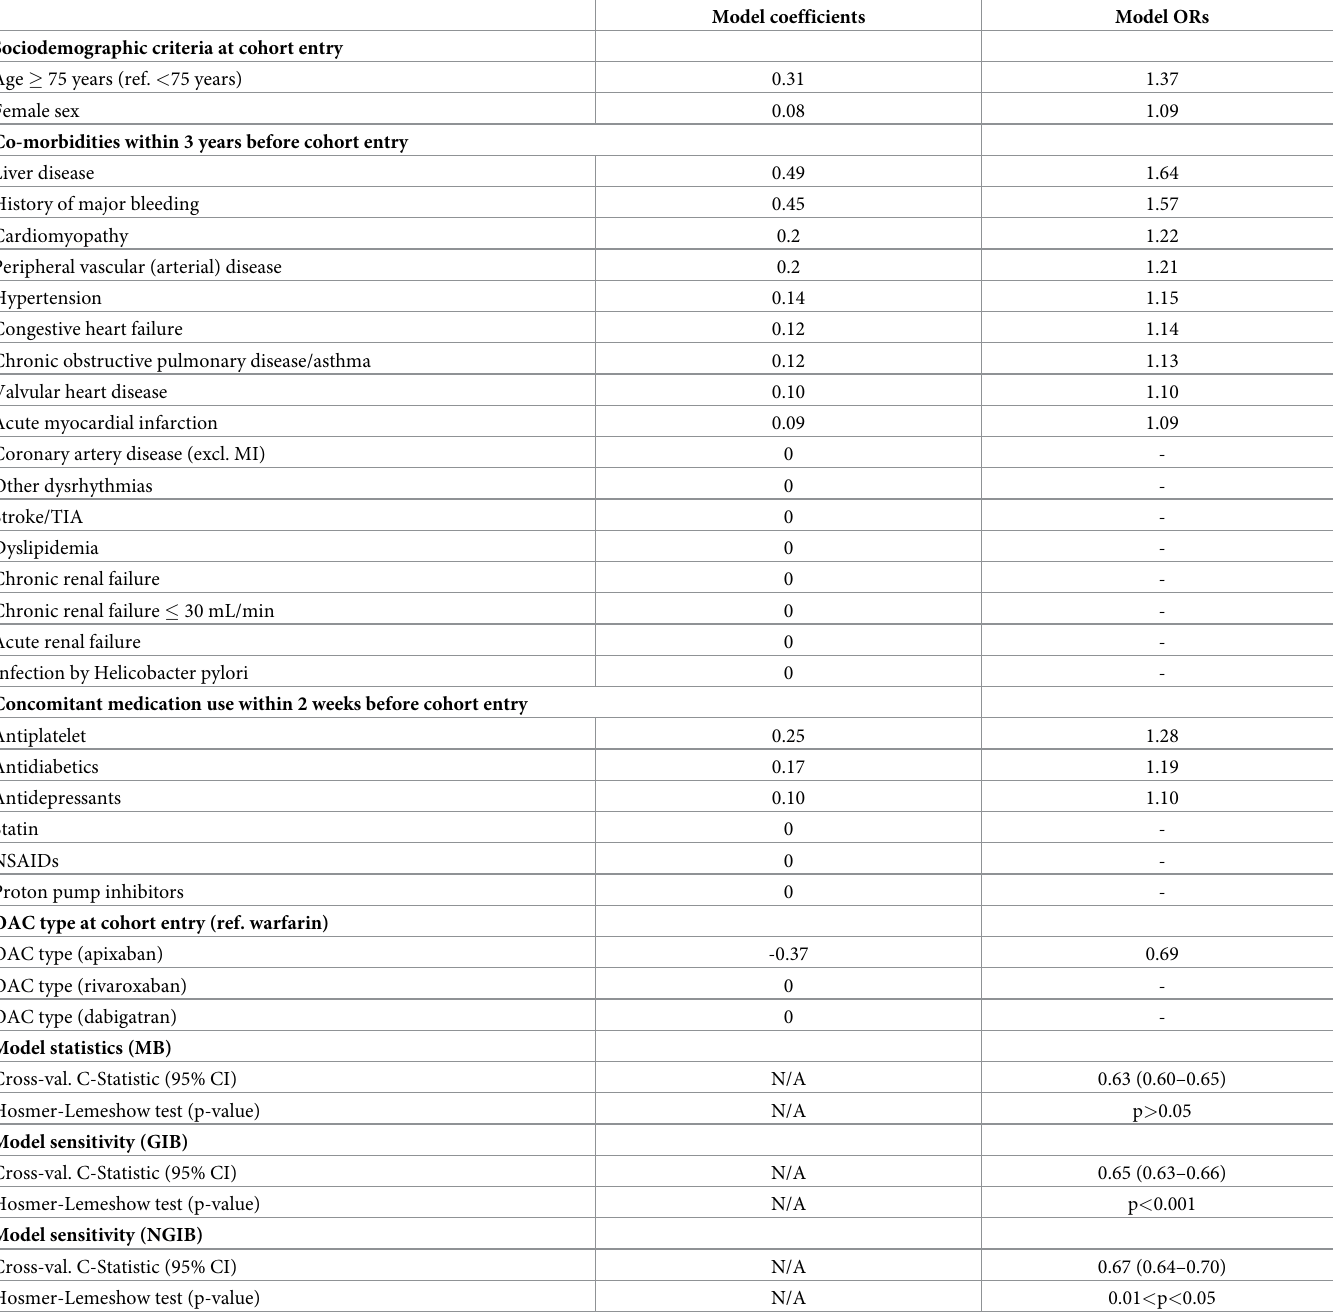
Table 3. The predictors selected into the primary prediction model of major bleeding and its